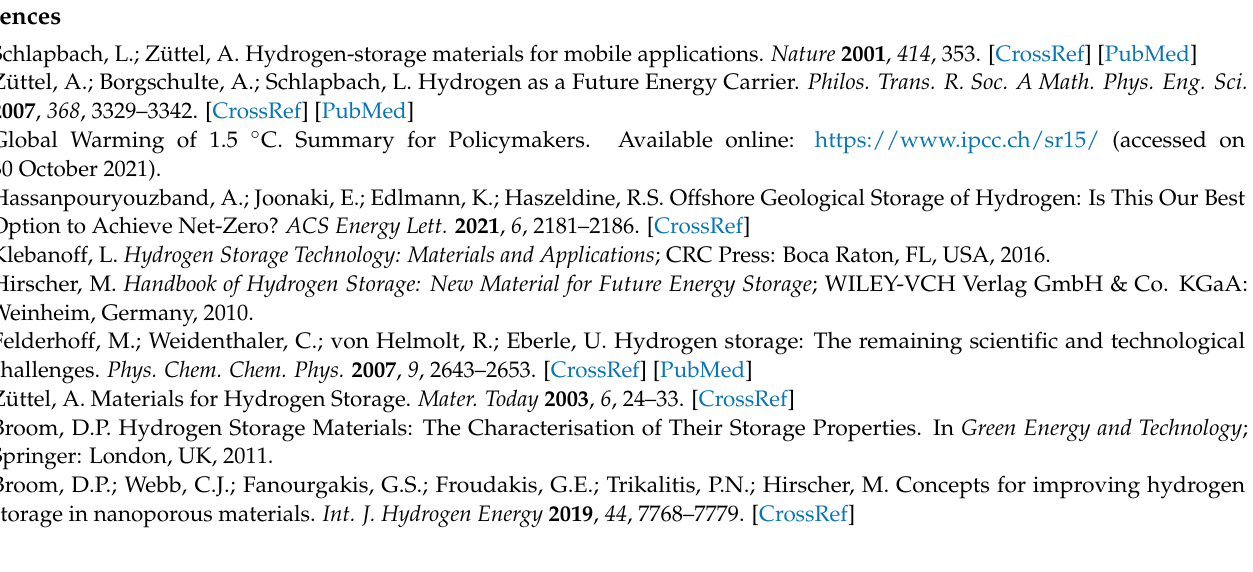
Table S4: Fitting parameters of the hydrogenation kinetic curves, Table S5: Fitting parameters of the dehydrogenation kinetic